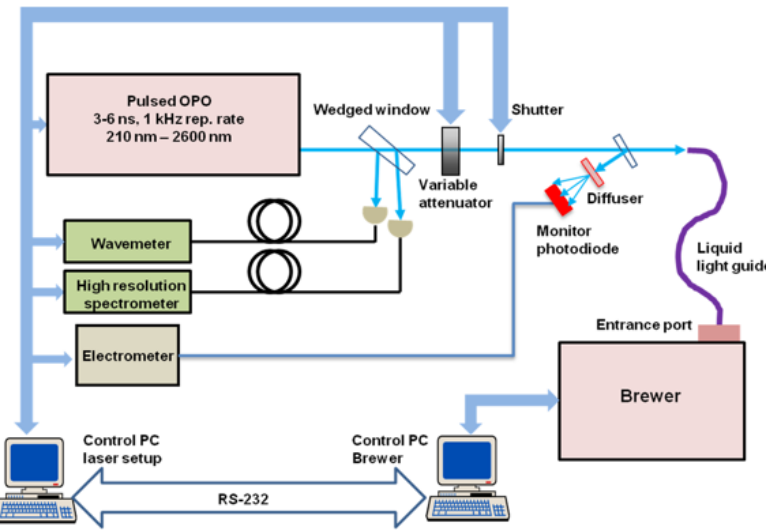
Figure 3. Pulsed OPO-based setup at PTB that was used for measuring the slit functions of the Brewer spectrophotometer.